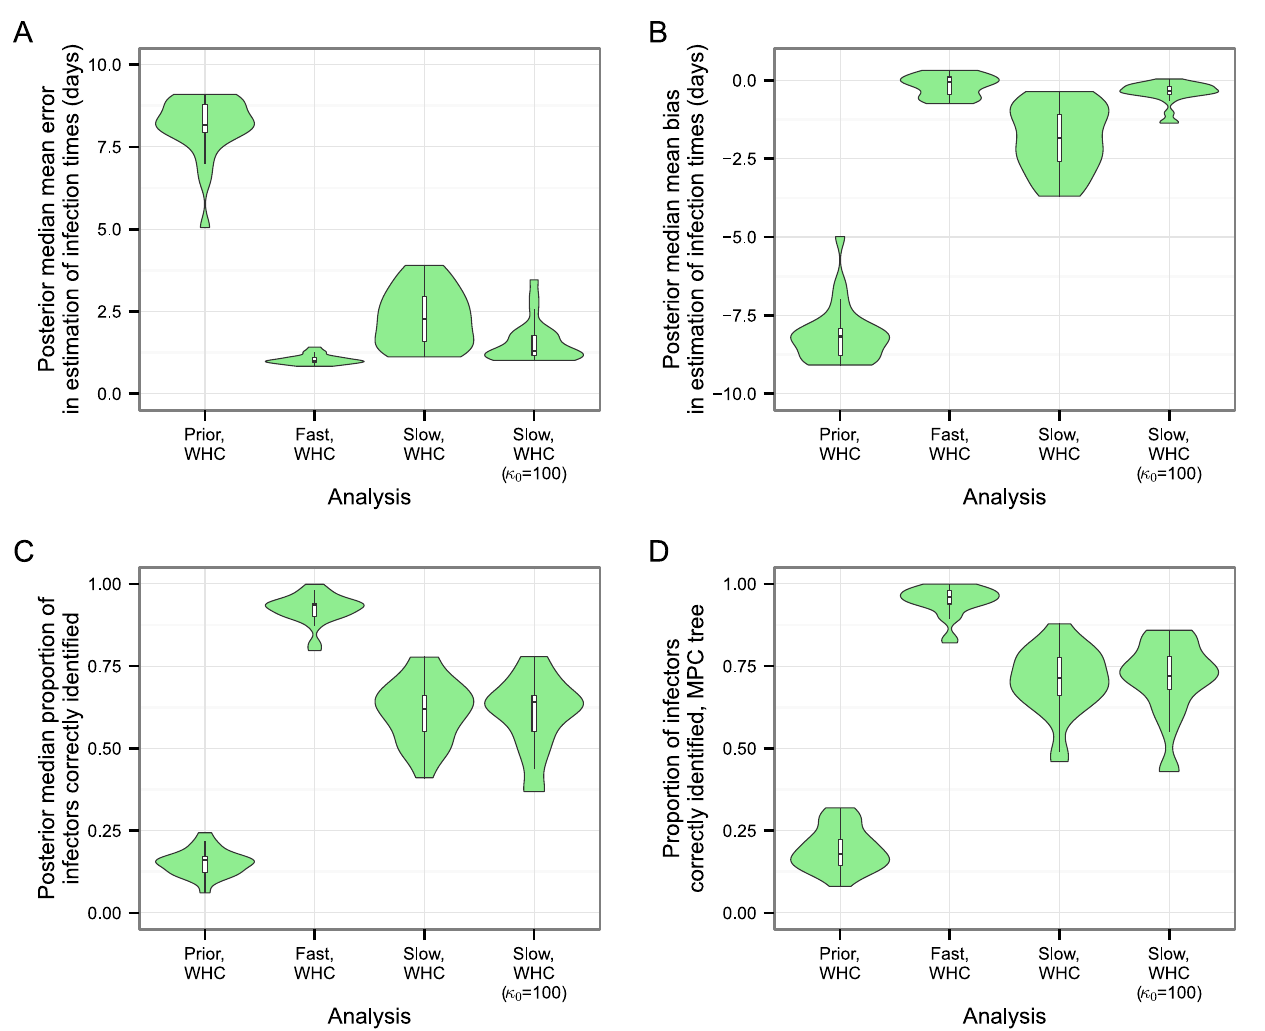
Fig 3. Accuracy of the reconstruction of the transmission tree. Each violin plot represents the density of a statistic calculated from the results of separate analyses of 25 simulated datasets; the clock model used to generate the dataset and the analysis method are indicated on the y -axis. (A) posterior median of mean bias in estimation of infection dates. (B) posterior median of mean error in estimation of infection dates. (C) Posterior median proportion of hosts whose infector is correctly identified. (D) Proportion of hosts whose infector is correctly identified in the maximum parent credibility (MPC) transmission tree.